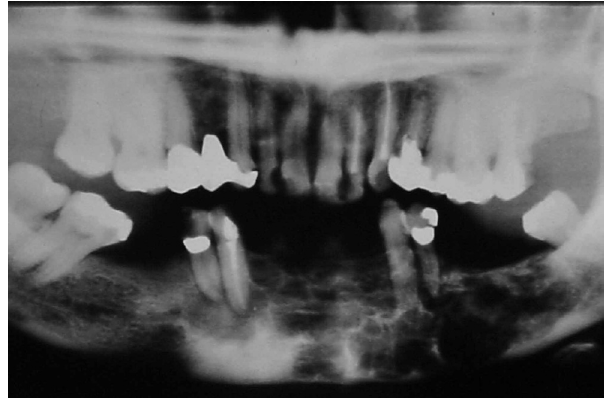
Figure 3 - Image of a extensive multilocular radiolucency from the lower left molar region to the right premolar region. The radiographic appearance resemble soap bubble patterns